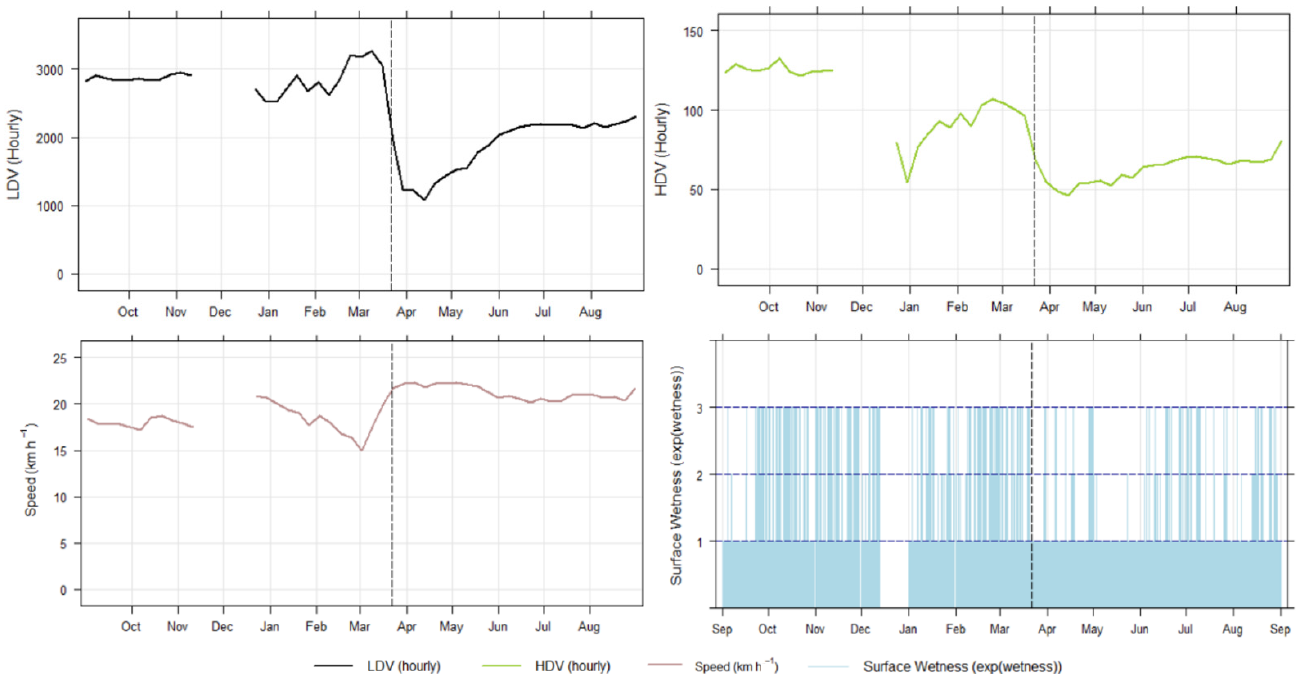
Figure 3. Weekly traffic volume (6-lanes hourly average by light-duty vehicles (LDV) and heavy-duty vehicles (HDV)) and speed (km h − 1 ) and the hourly exponential road surface wetness conditions (as defined in Section 2.2.4 [74]). There was a 31% reduction in LDV and 40% reduction in HDVs during lockdown, but there was a 15% increase in average speeds. The road surface wetness conditions prior to lockdown were notably higher than during lockdown. Missing traffic and surface wetness data are due to instrument failure.